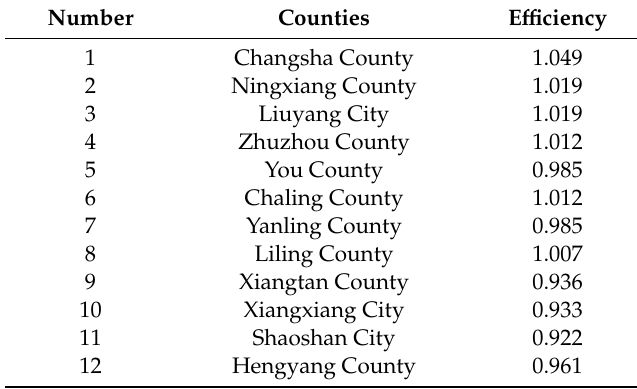
Table A1. TFP in 86 counties (county-level cities) in Hunan Province from 2009 to